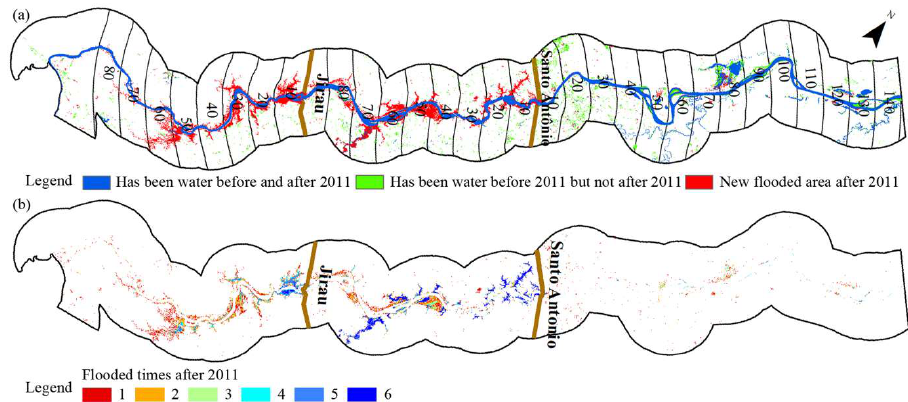
Figure 4. CUSUM (Cumulative Sum) of water area change in upstream, midstream, and downstream regions during 1985–2017.